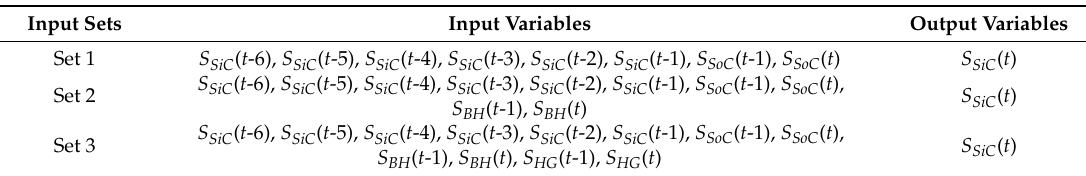
Table 1. Input combination for model